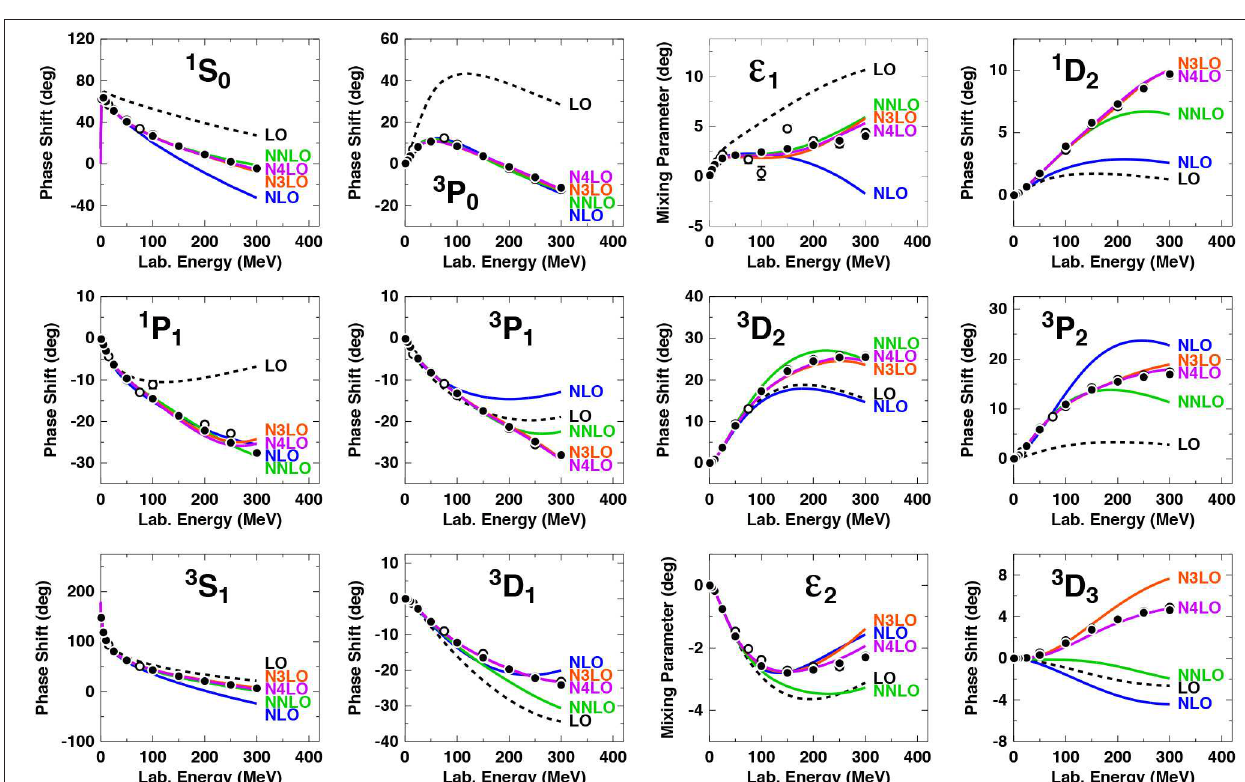
FIGURE 15 | Chiral expansion of neutron-proton scattering as represented by the phase shifts in S , P , and D waves and mixing parameters ǫ 1 and ǫ 2 . Five orders ranging from LO to N 4 LO are shown as denoted. A cutoff 3 500 MeV is applied in all cases. The filled and open circles represent the results from the Nijmegen = multi-energy np phase-shift analysis [93] and the GWU single-energy np analysis SP07 [95], respectively. Reprinted figure with permission from Entem et al. [37], copyright (2017) by the American Physical